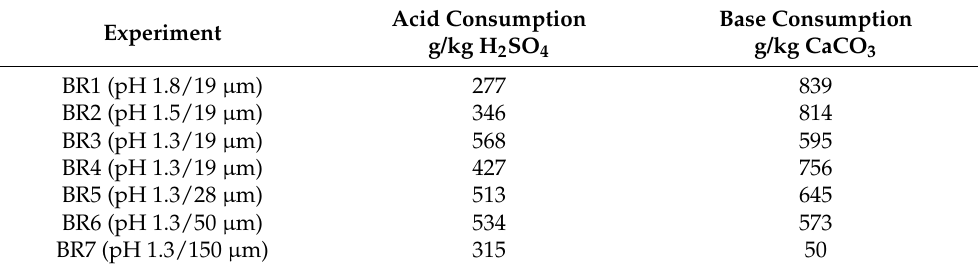
Table 6. The acid and base consumption in bioleaching tests, normalized to 95% H 2 SO 4 and pure 100% CaCO 3 use per kg of feed material.